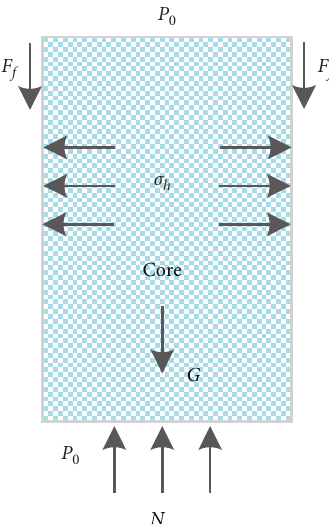
Figure 2: Mechanical schematic diagram of rock